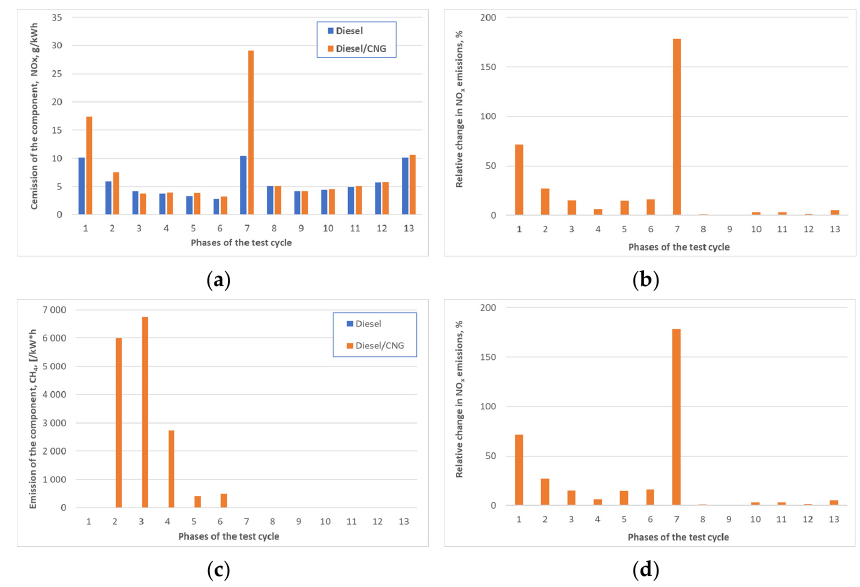
Figure 15. Emission of gaseous exhaust components during the R49 test on diesel fuel and die- sel/CNG supply for individual phases of the test: ( a ) emission of nitrogen oxides (NO x ), ( b ) relative change in NO x emission, ( c ) emission of CH 4 and ( d ) relative change in CH 4 emission.